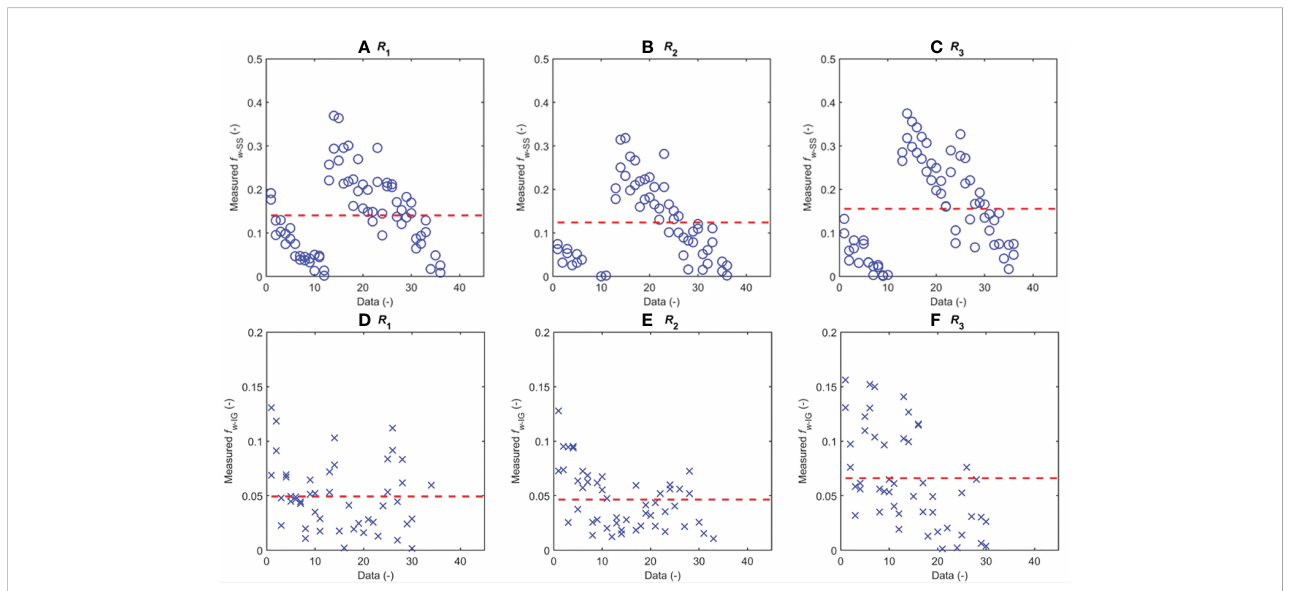
FIGURE 11 Measured energy dissipation coef fi cient due to bottom friction for SS-waves (A-C) and IG-waves (D-F) .